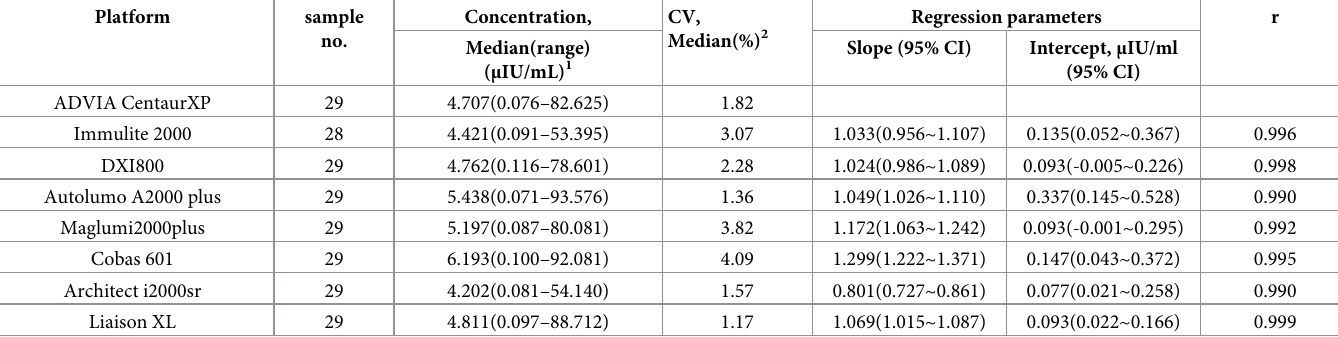
Table 1. Passing–Bablok regression analysis measured TSH values for patient samples after systematic biases were corrected. Platform sample no.